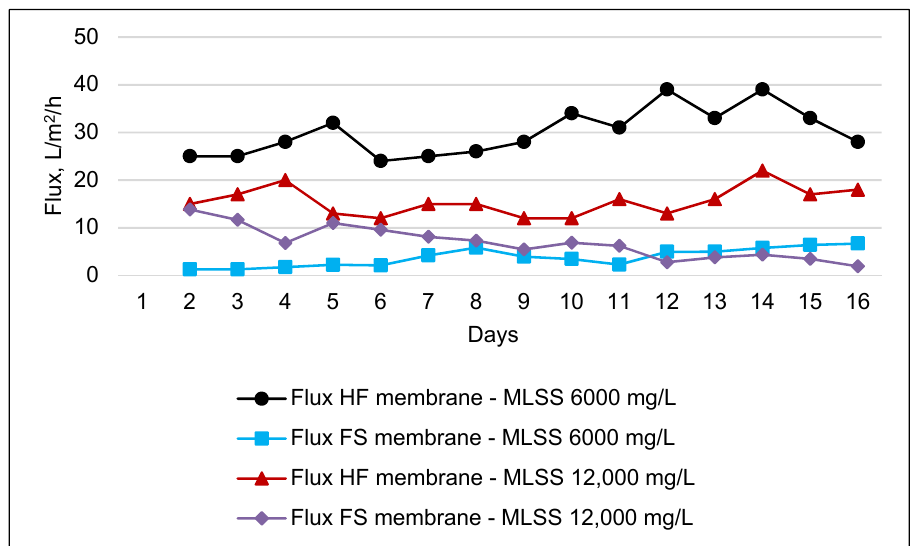
Figure 8. Flux trend for HF and FS membranes by using MLSS values of 6000 mg/L and 12,000 mg/L.